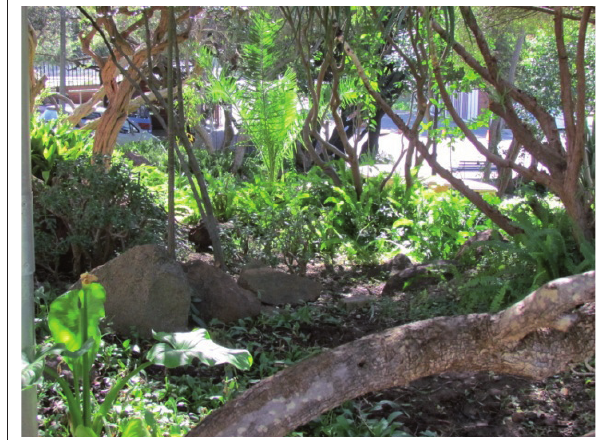
FIGUUR 12: ‘Daar was ŉ klip wat ŉ rekenaar